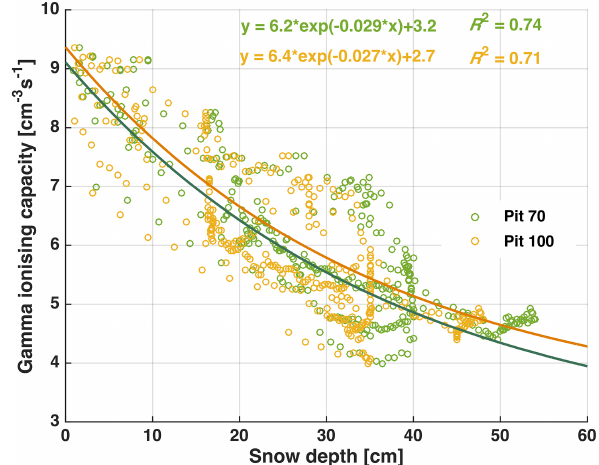
Figure 7. The attenuation effect of total gamma radiation by snow cover for the years 2003–2006. Pit 70 and 100 are two measurement points of snow cover depth. Exponential fittings were made with the goodness of fit denoted as R 2 . The 95% confidence bounds for the constant term are [2.2 4.1] and [1.3 4.0] for pit 70 and pit 100,